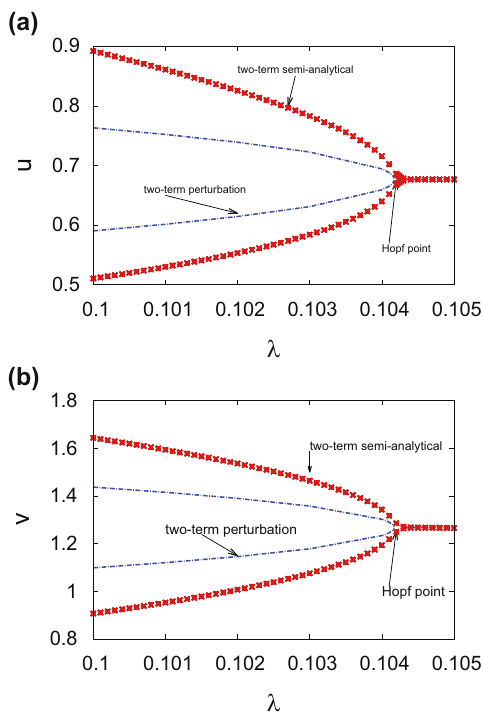
Figure 13: Bifurcation diagrams for ( a ) autocatalyst u and ( b ) reactant v concentrations, respectively, against bifurcation parameter λ . The two - term semi - analytical and perturbation results for the parameter values